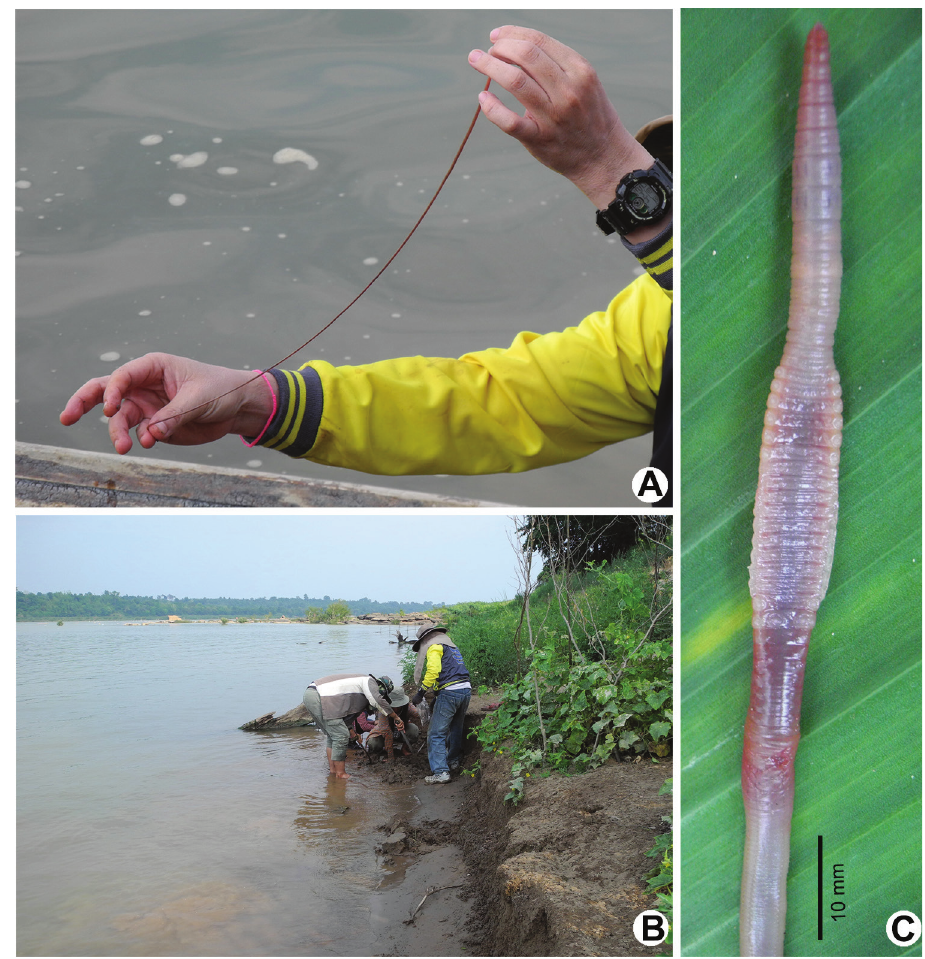
Figure 11. Photographs showing the A Glyphidrilus champasakensis sp. n. B type locality of G. cham- pasakensis sp. n. in the banks of Mekong River at Ban Khonkhen, Champasak, Laos and C coloration of newly collected paratype (CUMZ 3427) after the first preservation step in 30% (v/v) ethanol.